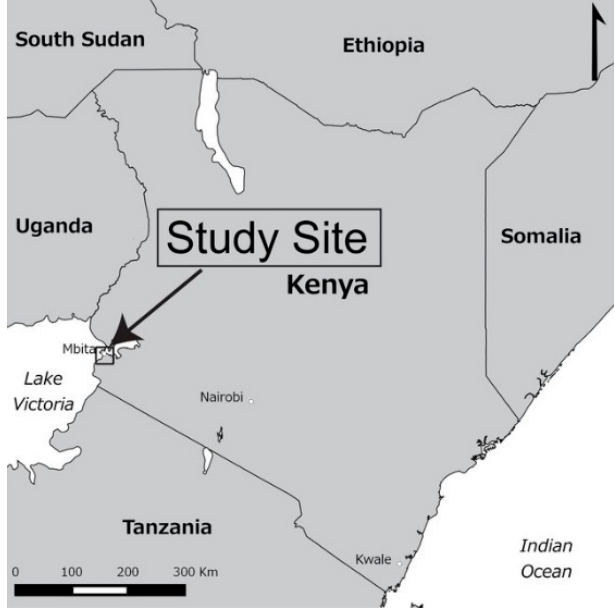
Figure 3. Study Location: Mbita, Kenya along the shore of Lake Victoria [17].